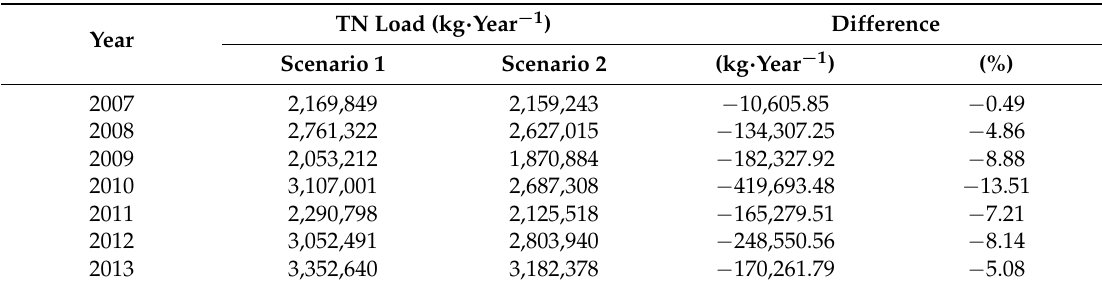
Table 4. Annual TN load (kg-N) for scenario analysis.